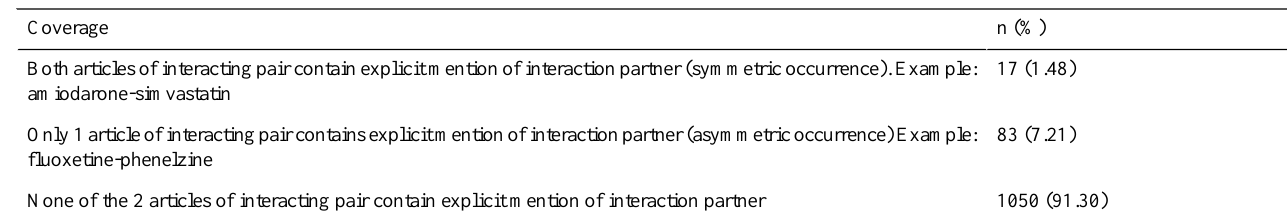
Table 1. Statistics on coverage of drug-drug interaction (DDI) data in existing English Wikipedia articles compared to the ONC high priority list for 1150 DDI pairs